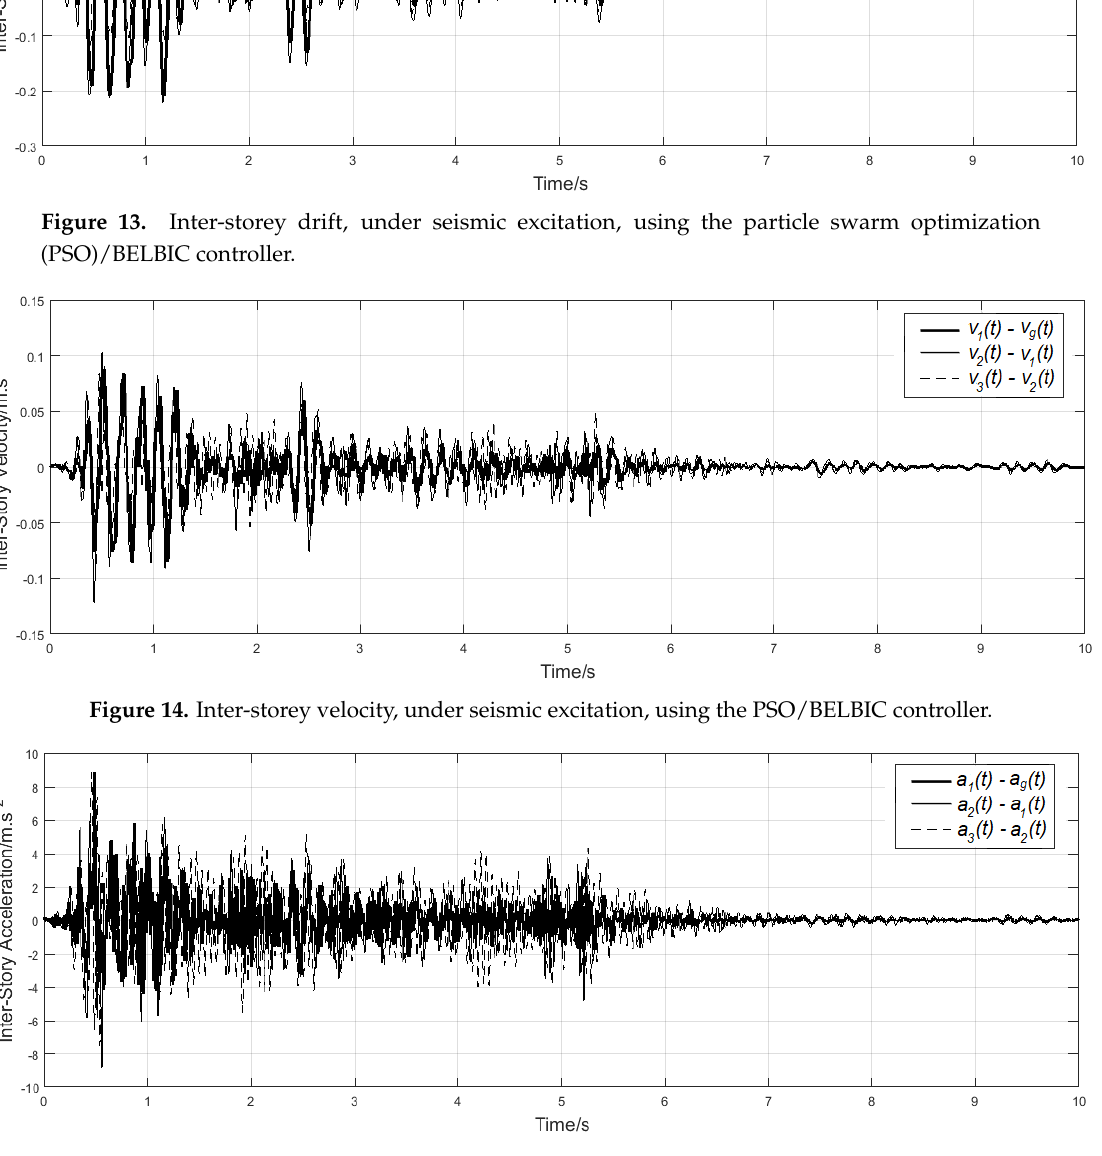
Figure 15. Inter-storey acceleration, under seismic excitation, using the PSO/BELBIC